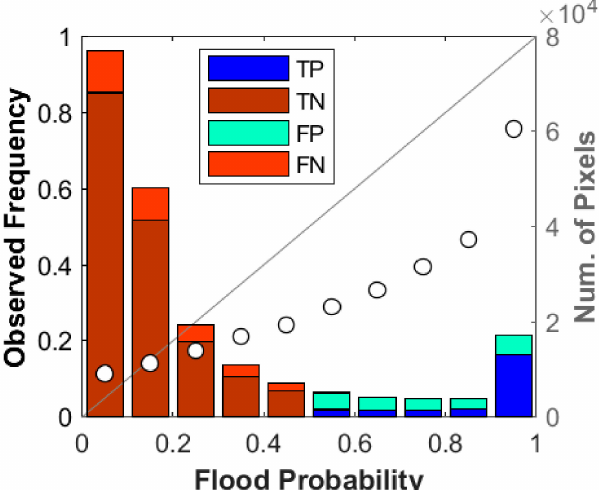
Figure 8. The reliability diagram between the flood probability p F and the observed frequency p o (white circles). The number of pixels for each probability bin is shown in vertical bars color-coded by contingency types. The deviation of the circles from the 1:1 line represents the error for each probability bin. The pixel counts in di ff erent contingency types shows that the error comes from FN (underprediction) for probability bins below 0.5, and FP (overprediction) for probability bins above